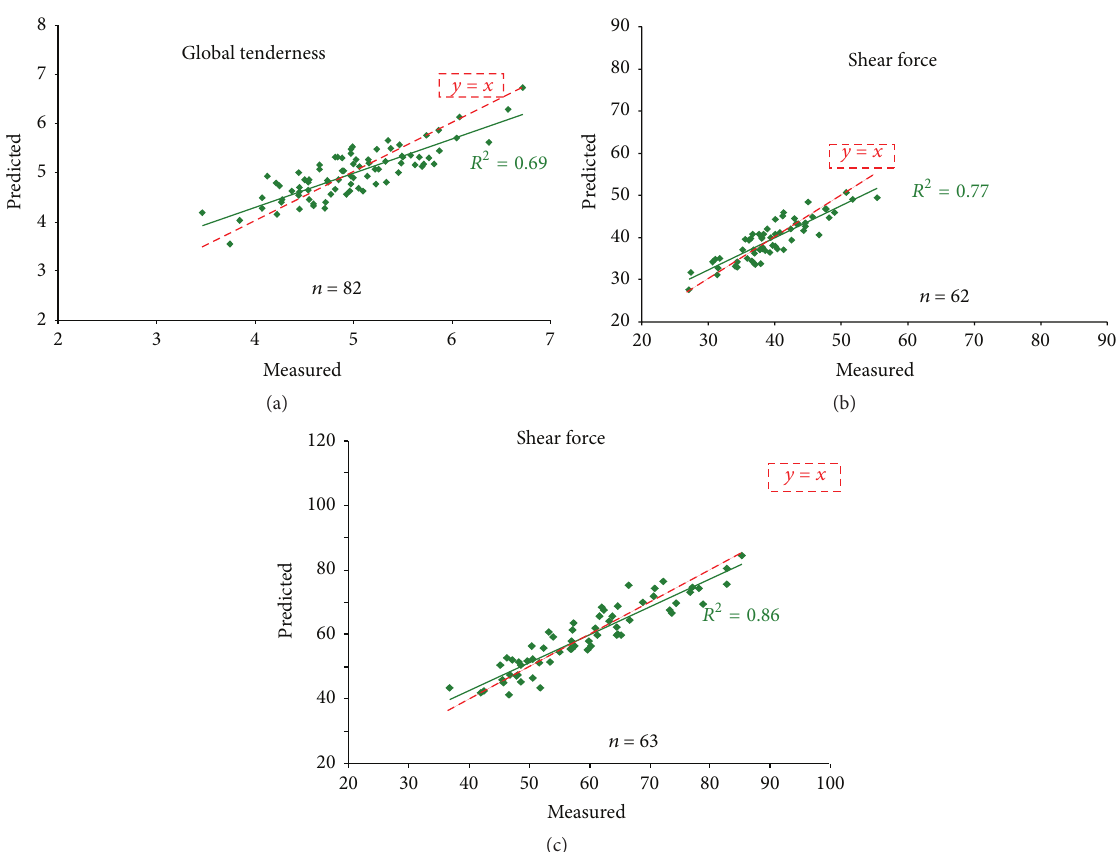
Figure 3: Equation of prediction using 24 protein biomarkers of (a) global tenderness evaluated by sensory analysis with trained panellists (scores from 1 to 10) on longissimus thoracis muscle, (b) shear force measured by Warner-Bratzler test (N/cm 2 ) on longissimus thoracis muscle, and (c) shear force measured by Warner-Bratzler test (N/cm 2 ) on semitendinosus muscle, in Charolais young bulls.